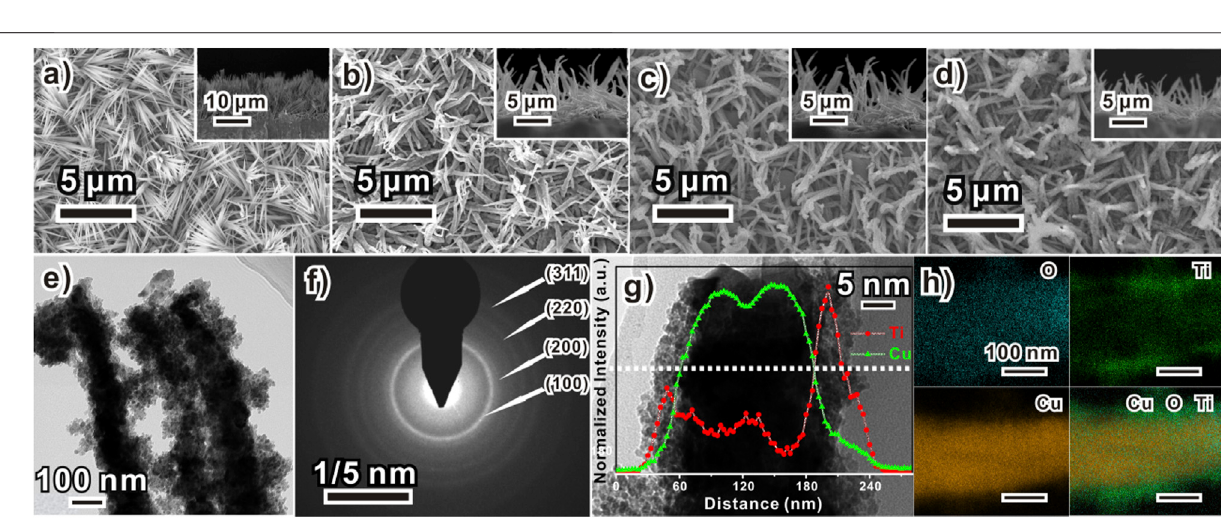
Frontiers in Chemistry |